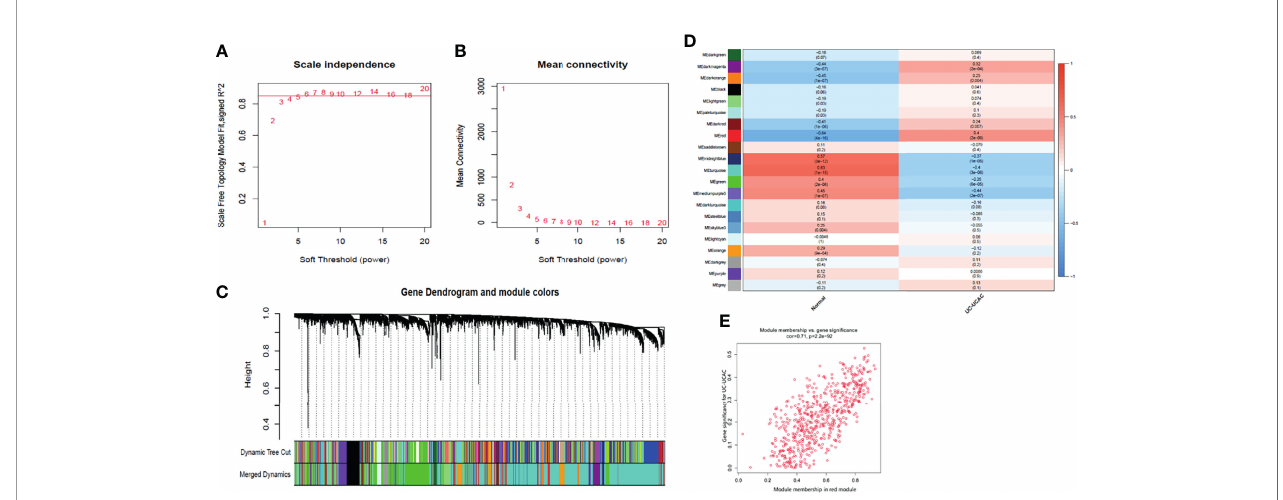
FIGURE 2 | Identi fi cation of modules associated with the clinical information in the WGCNA. (A) Analysis of the scale ‐ free fi t index for various soft ‐ thresholding powers ( b ). (B) Analysis of the mean connectivity for various soft ‐ thresholding powers. (C) Dendrogram of all differentially expressed genes clustered based on a dissimilarity measure (1 ‐ TOM). (D) Module – trait relationships. Each cell contains the corresponding correlation and P value. (E) A scatter plot of gene signi fi cance for UC-UCAC vs. the membership in the red module. TOM, topological overlap matrix; WGCNA, weighted gene co-expression network